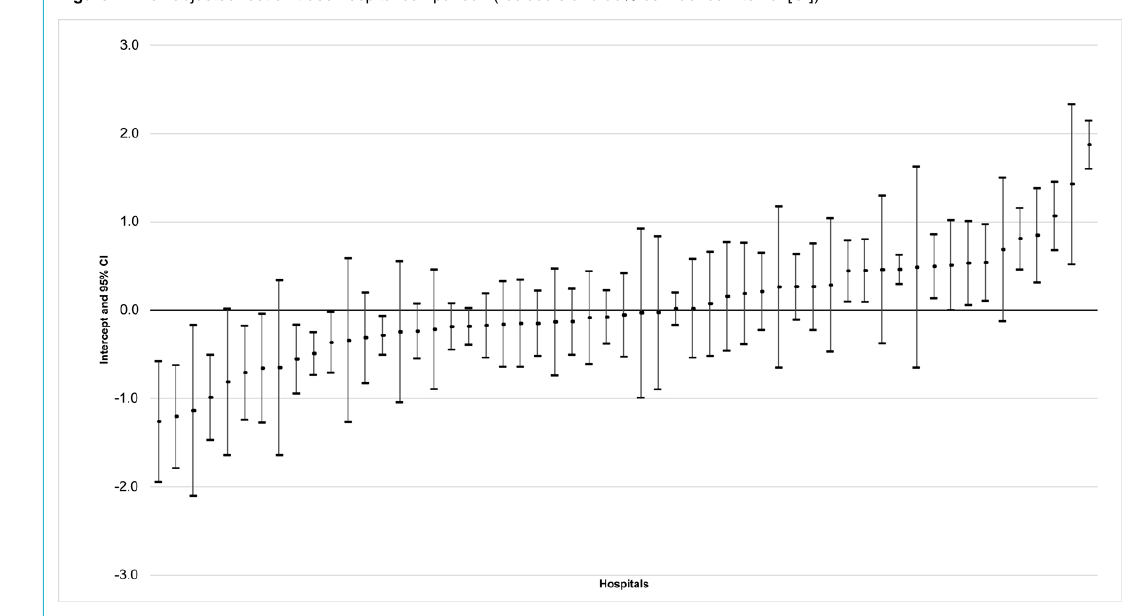
Figure 1: Risk-adjusted restraint use hospital comparison (residuals and 95% confidence interval